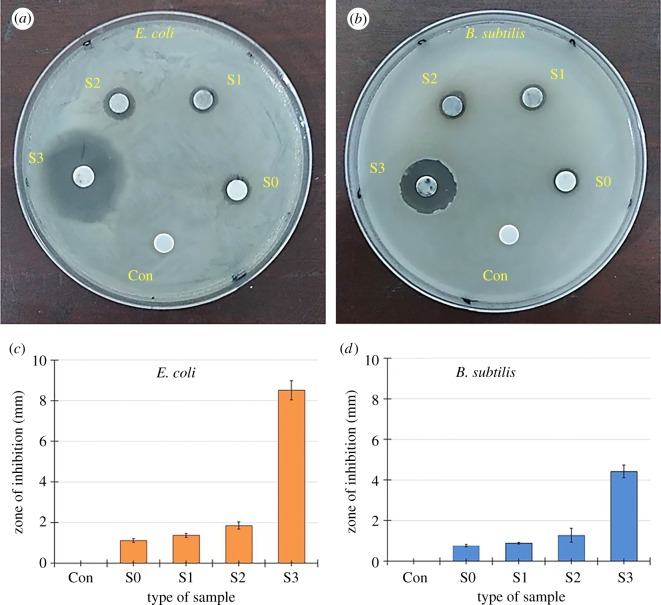
Representative images of (a) E. coli and (b) B. subtilis agar plates showing ZOI around discs impregnated in samples S0, S1, S2, S3 and pure water (Con). The graphical representation of all measured ZOI against (c) E. coli and (d) B. subtilis.